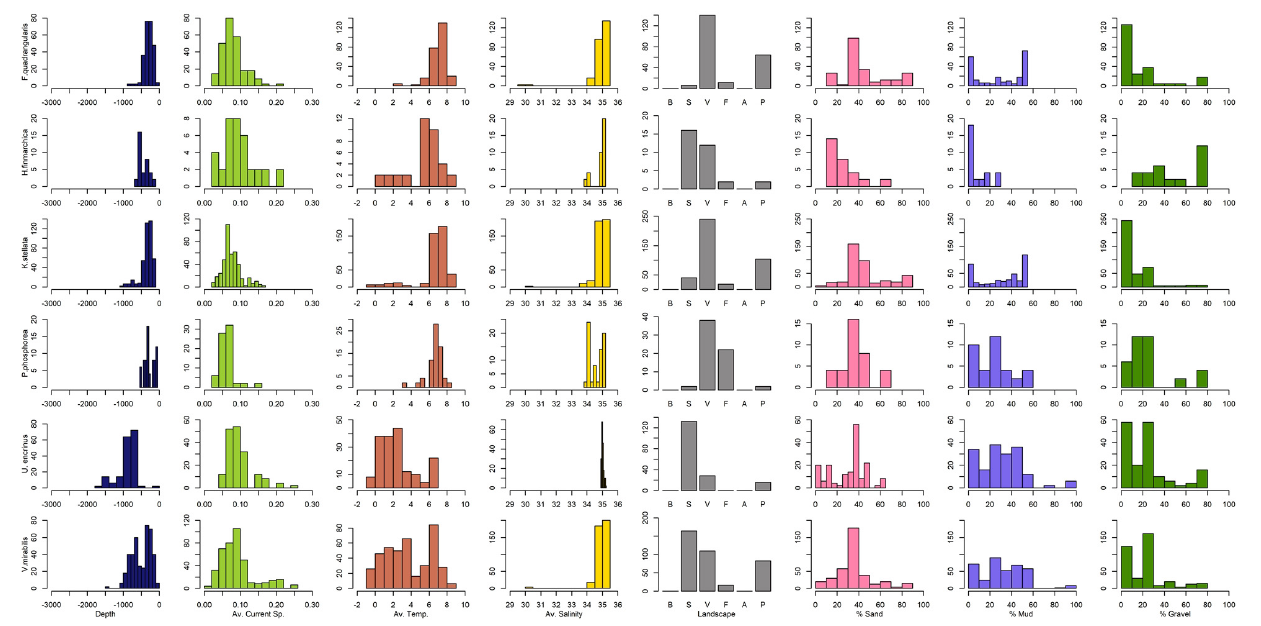
FIGURE 2 | Selected histograms showing the distribution of presence locations relative to each environmental variable. Further histograms are available in Supplementary Material . The x -axis is scaled to show all possible values within the sampled area (values beyond this range may be present in the greater study area). Landscape categories represent: B, sandbank/strandflat; S, slope; V, valley/canyon; F, fjord; A, abyss; P, shelf plain. Sediment values are shown only for where sediment data is available – these three categories are scaled to the maximum y -axis of the three to better visually assess the proportion of one relative to